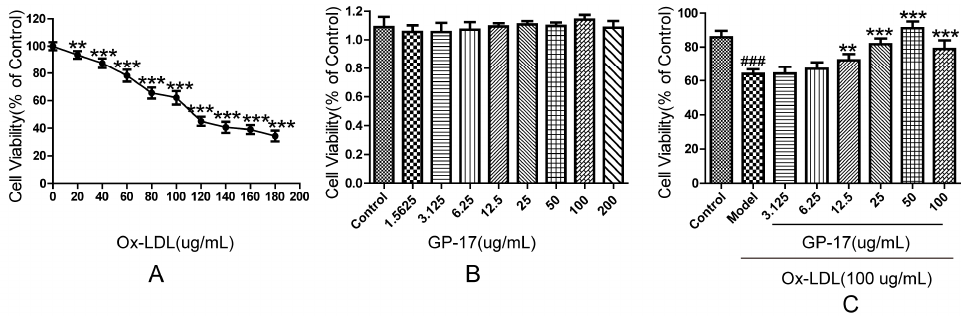
Figure 5. Cytoprotective effects of GP-17 on Ox-LDL-induced cytotoxicity in HUVECs. ( A ) HUVECs were treated with Ox-LDL at different concentrations for 24 h. Cell viability was measured by MTT assays; ( B ) Cell viability of HUVECs incubated with different concentrations of GP-17 for 12 h; ( C ) Incubation with GP-17 significantly lowered Ox-LDL-induced cell injury. Cell viability was measured by MTT assays. The values are expressed as the mean ± S.E.M. from three independent experiments. ### p < 0.001 vs. Control; ** p < 0.01; *** p < 0.001 vs. Model. MTT, 3-(4,5-dimethylthiazol-